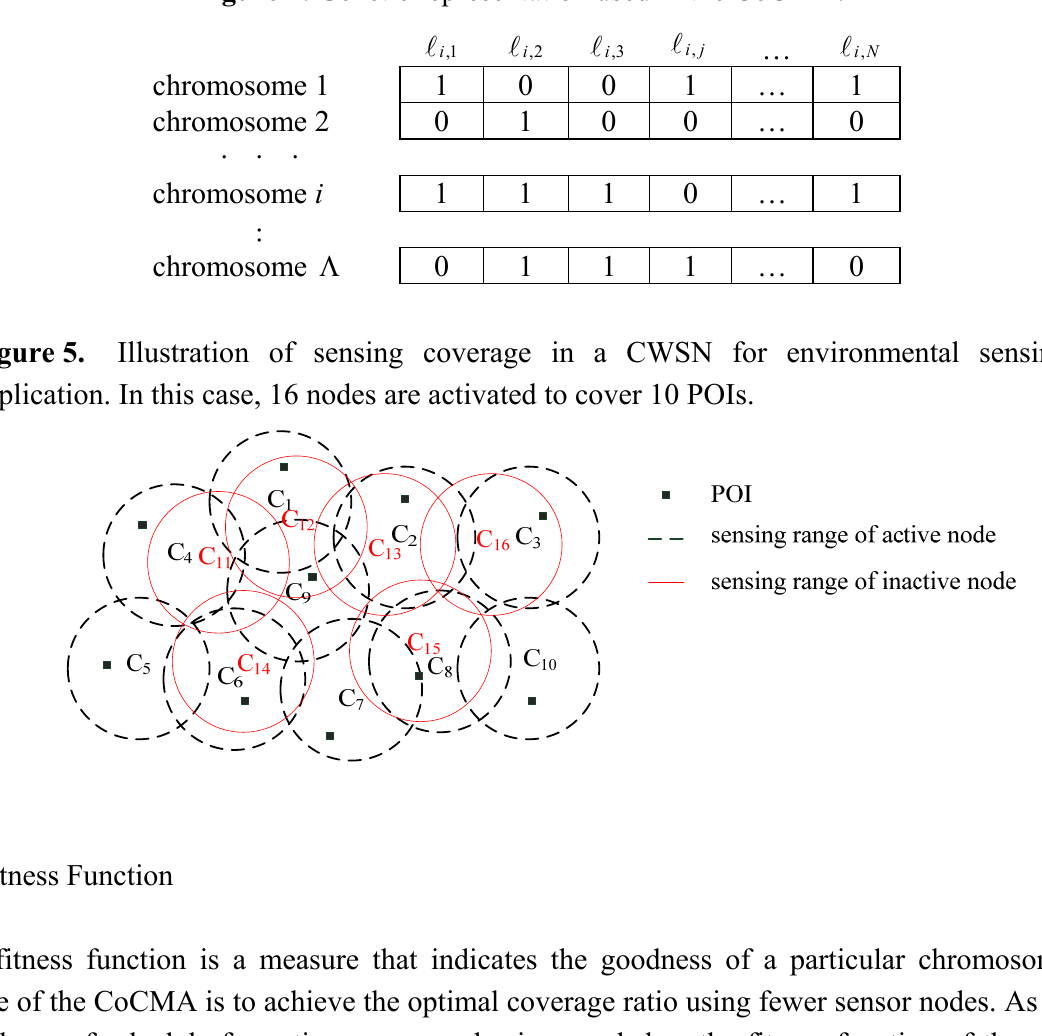
Figure 4. Genetic representation used in the CoCMA.